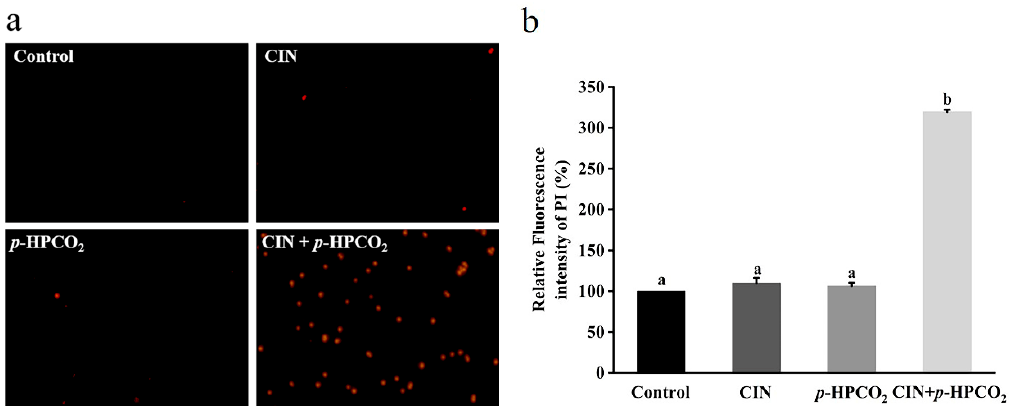
Figure 5. Fluorescence microscopic images of Saccharomyces cerevisiae cells stained with propidium iodide (PI) (×400) ( a ) and relative fluorescence intensity of PI in S. cerevisiae ( b ). S. cerevisiae cells were treated with individual and combined treatments with cinnamon oil (CIN) (0.02%) and petit -high pressure CO 2 ( p -HPCO 2 ) (1.3 MPa) for 2 h at 25 °C. Different letters above bars indicate significant differences ( p < 0.05).